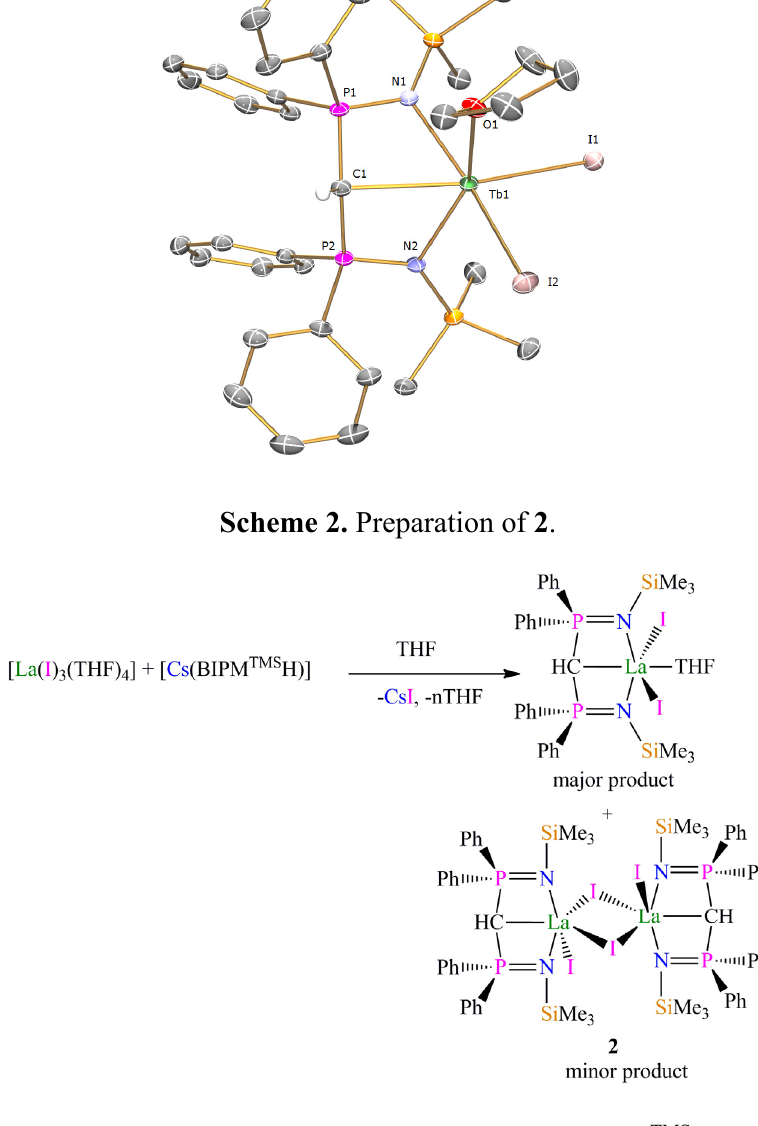
H with selected atom labelling. Displacement 4 8